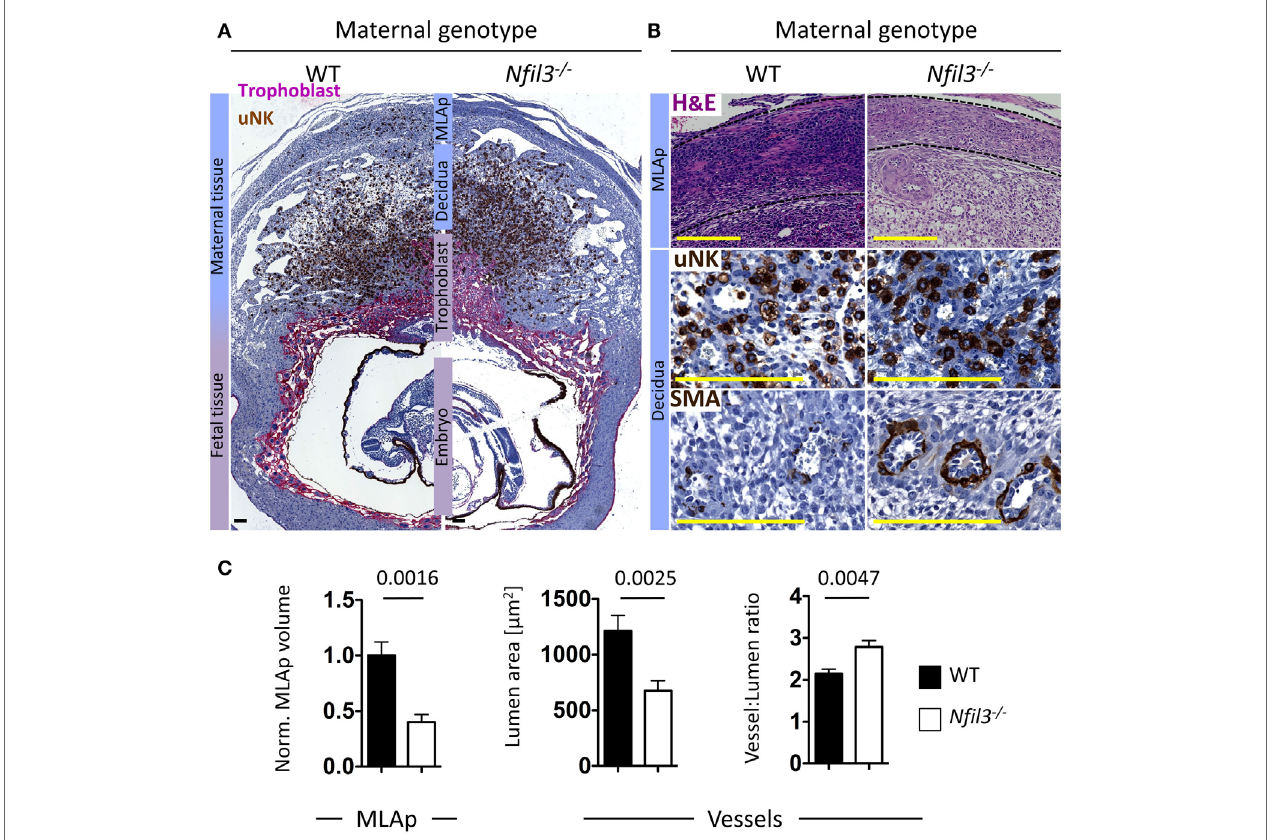
FigUre 3 | abnormalities in uterine tissues of Nfil3 − / − dams . (a) Representative immunohistological staining of gd9.5 implantation sites from WT and Nfil3 − / − pregnant females mated with WT males. DBA + uNK cells (brown) within the mesometrial lymphoid aggregate of pregnancy (MLAp) and the decidua and in proximity of the invading trophoblast, which is stained with cytokeratin (purple). Bar = 500 μ m. (B) H&E and immunohistological staining of MLAp and decidua at higher magnification showing MLAp area, distribution of uNK around vessels, and presence of residual smooth muscle actin (SMA) within the vascular wall. Bar = 500 μ m. Indicated is the maternal geotype. All females were mated with WT males. (c) Stereological quantification of MLAp (left), vascular lumen area (middle), and relative wall thickness (right). Means ± SEM of data representative of 4–6 litters per genotype. Statistical differences were calculated with an unpaired Student’s t